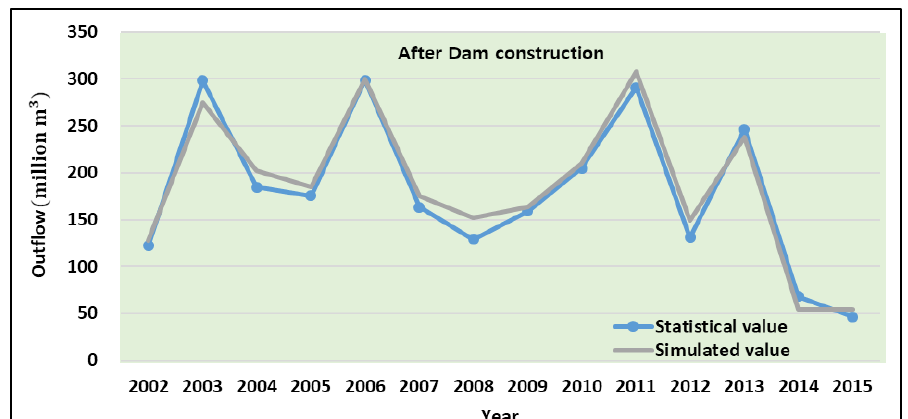
Figure 9. Calibration results—dam outflow.